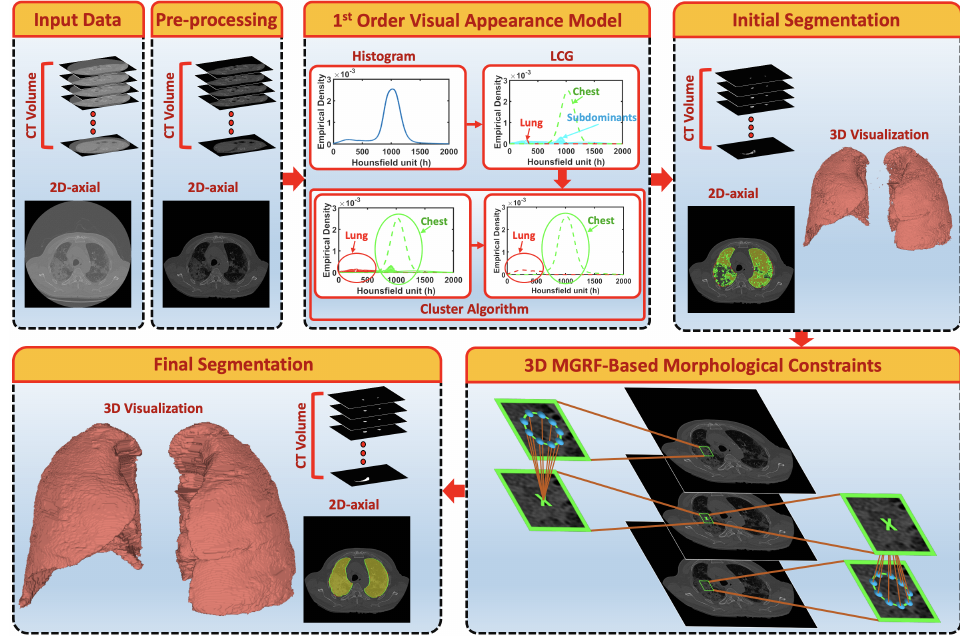
Figure 1. Schematic illustration of the pipeline of the proposed segmentation system using CT